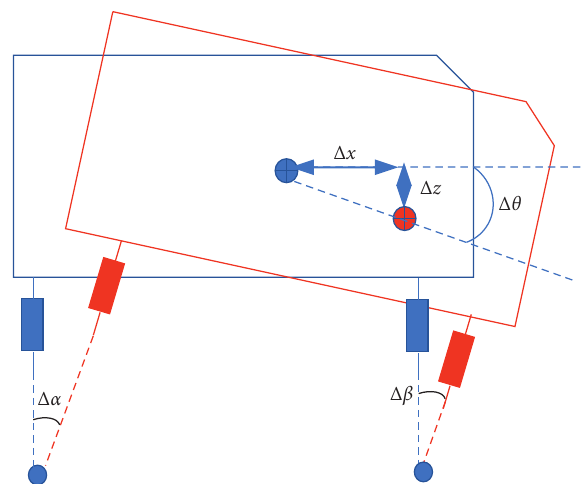
Figure 5: Schematic diagram of pitch motion of